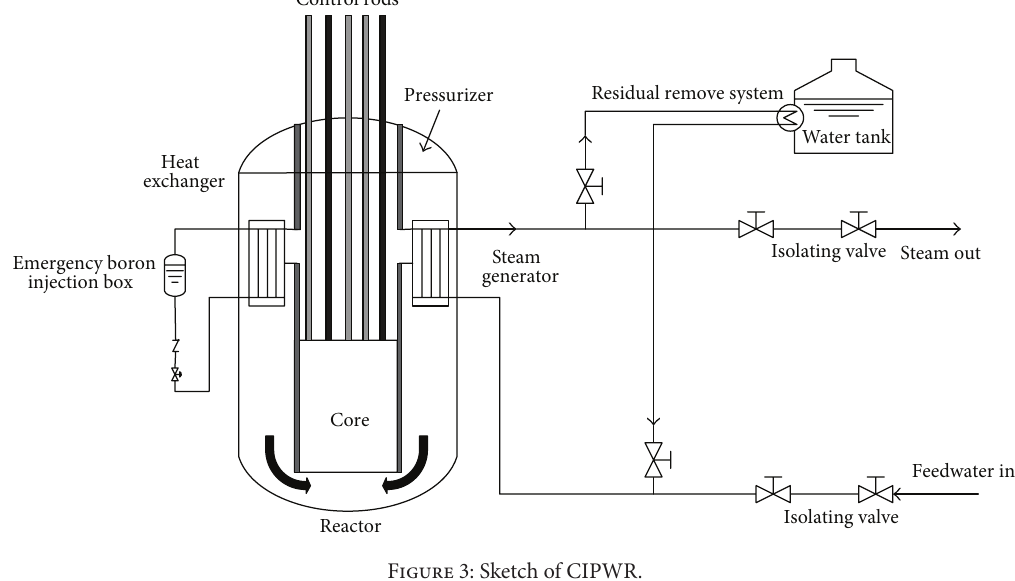
Figure 3: Sketch of CIPWR.